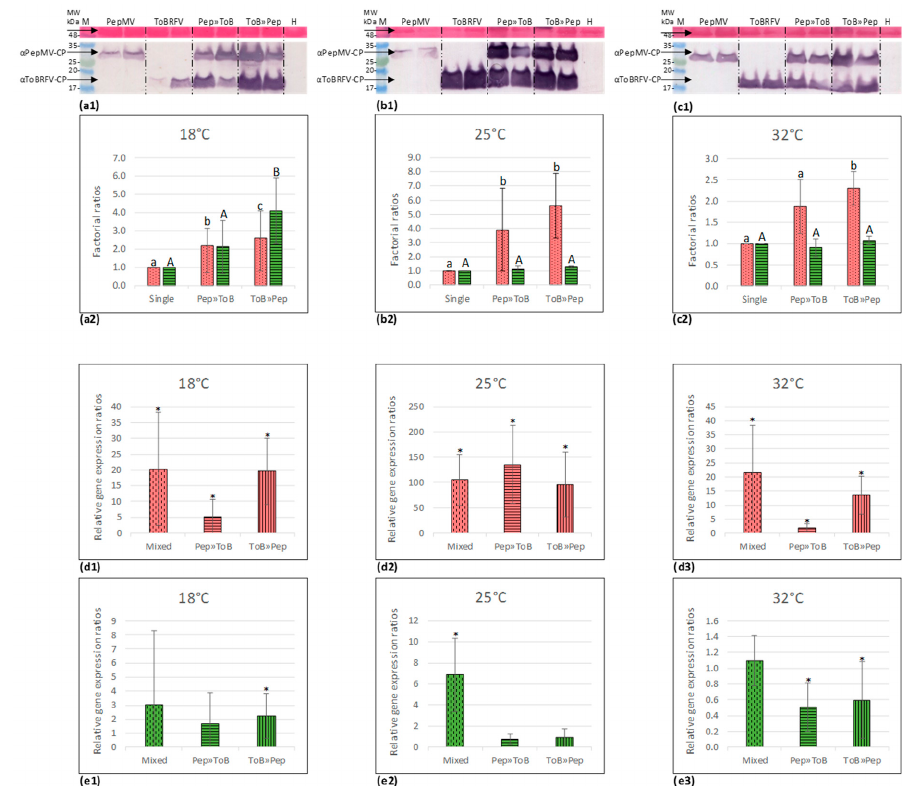
Figure 6. Enhanced pepino mosaic virus (PepMV) titers in tomato plants, successively inoculated with tomato brown rugose fruit virus (ToBRFV) and PepMV, compared to PepMV singly inoculated plants, occurred at both low and high environmental temperatures. ( a )–( c ) Western blot analyses results. ( d ), ( e ) Graphical depictions of viral relative gene expression ratios (2 - ∆∆ Ct ) calculated from quantitative RT-PCR results. ( a1 ) A Western blot analysis showing coat protein (CP) levels of ToBRFV and PepMV in singly and various mixed-inoculated tomato plants grown at 18 ◦ C. ( a2 ) A graphical depiction of a calculated mean factorial increase in viral CP levels in the two sequentially mixed-inoculated plants compared to singly inoculated plants grown at 18 ◦ C, using ImageJ software for band intensity measurements ( n = 4). ( b1 ) A Western blot analysis showing ToBRFV and PepMV CP levels in singly and various mixed-inoculated tomato plants grown at 25 ◦ C. ( b2 ) A graphical depiction of a calculated mean factorial increase in viral CP levels in the two sequentially mixed-inoculated plants compared to singly inoculated plants grown at 25 ◦ C ( n = 4). ( c1 ) A Western blot analysis showing ToBRFV and PepMV CP levels in singly and various mixed-inoculated tomato plants grown at 32 ◦ C ( n = 4). ( c2 ) A graphical depiction of a calculated mean factorial increase in viral CP levels in the two sequentially mixed-inoculated plants compared to singly inoculated plants grown at 32 ◦ C ( n = 4). H, healthy control; M, molecular size marker; arrows indicate the two viral CPs and a constantly expressed plant protein stained by Ponceau-S dye. Dotted columns represent PepMV results; striped columns represent ToBRFV results; bars indicate the standard deviation of the mean; a, b, c, indicate statistically significant PepMV results between the marked columns, p < 0.05; A, B, C, indicate statistically significant ToBRFV results between the marked columns, p < 0.05; statistical analyses: t -Test: Two sample assuming unequal variances. ( d1 – 3 ) PepMV relative gene expression ratios in the various mixed-infected tomato plants at three di ff erent environmental temperatures. ( e1 – 3 ) ToBRFV relative gene expression ratios in the various mixed-infected tomato plants at three di ff erent environmental temperatures. Asterisks (*) indicate a significant increase in viral relative gene expression ratios ( p < 0.05), determined by subjecting the di ff erence between viral ∆ Ct obtained in mixed infections and that obtained in single infections (comprising the derived viral ∆∆ Ct), to t -Test: Two sample assuming unequal variances. PepMV results are pink colored; ToBRFV results are green colored; ToB, ToBRFV; Pep, PepMV; n , number of total